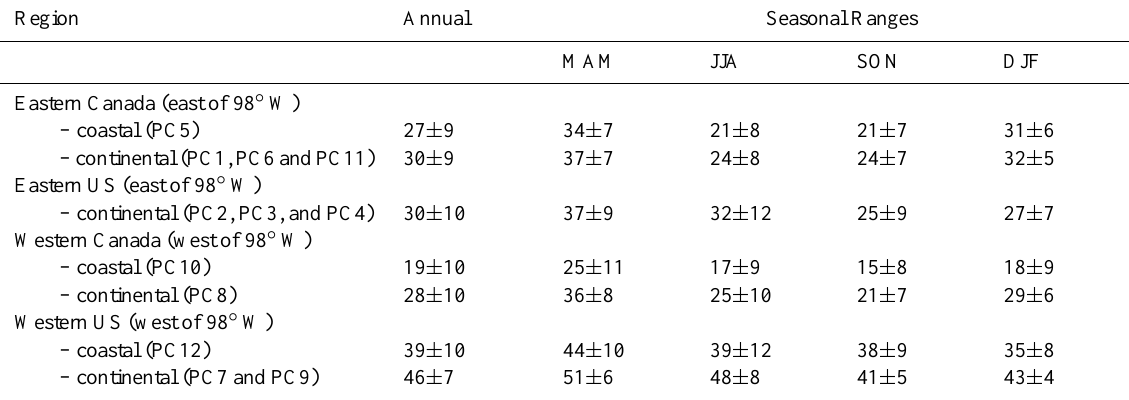
Table 1. Summary of annual and seasonal average ( ± 1 standard deviation) baseline ozone mixing ratios (ppb) for seven geographical regions, i.e. Coastal/Continental Eastern Canada, Continental Eastern US, Coastal/Continental Western Canada, and Coastal/Continental Western US. Symbols correspond to Fig. 1: PC1 (red triangles), PC2 (green diamonds), PC3 (blue squares), PC4 (purple stars), PC5 (pink circles), PC6 (orange hexagons), PC7 (yellow spades), PC8 (pink #), PC9 (cyan clubs), PC10 (magenta inverse triangles), PC11 (brown pluses), and PC12 (yellow